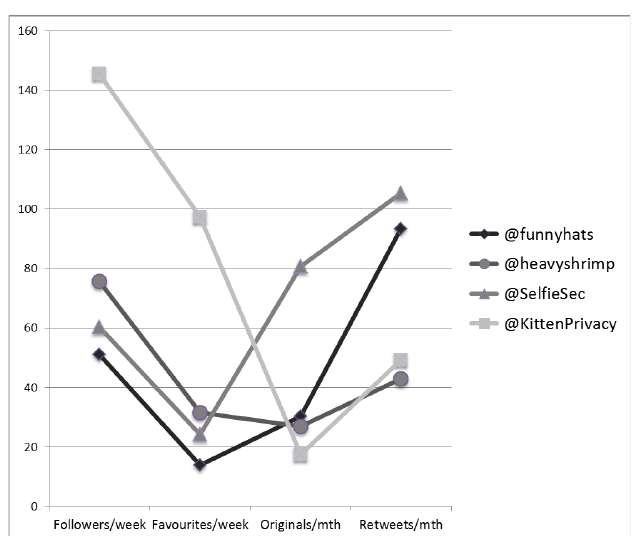
Fig. 2 . The average numbers of followers/week and favourites/week , and of original tweets/month and retweeted tweets/month for the four case accounts between account set up and mid-December